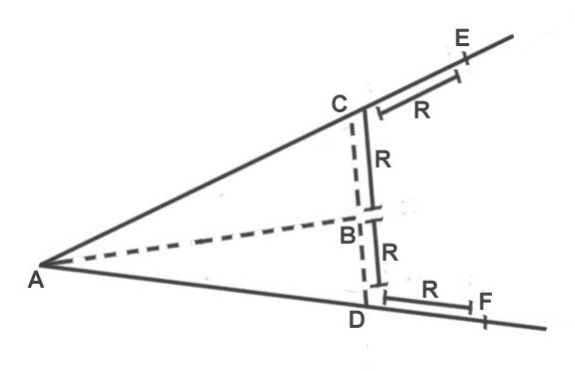
Figure 3. Trilateral zone.